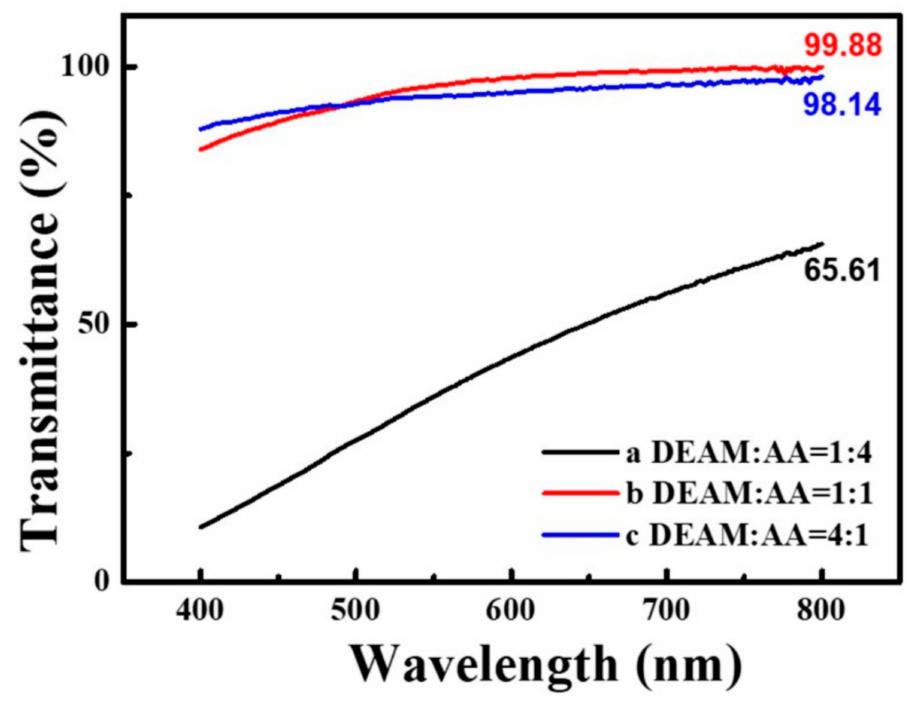
Figure 3. Transmittance spectra of PADA gel electrolytes with different volume ratios of DEAM and AA at wavelengths of 400–800